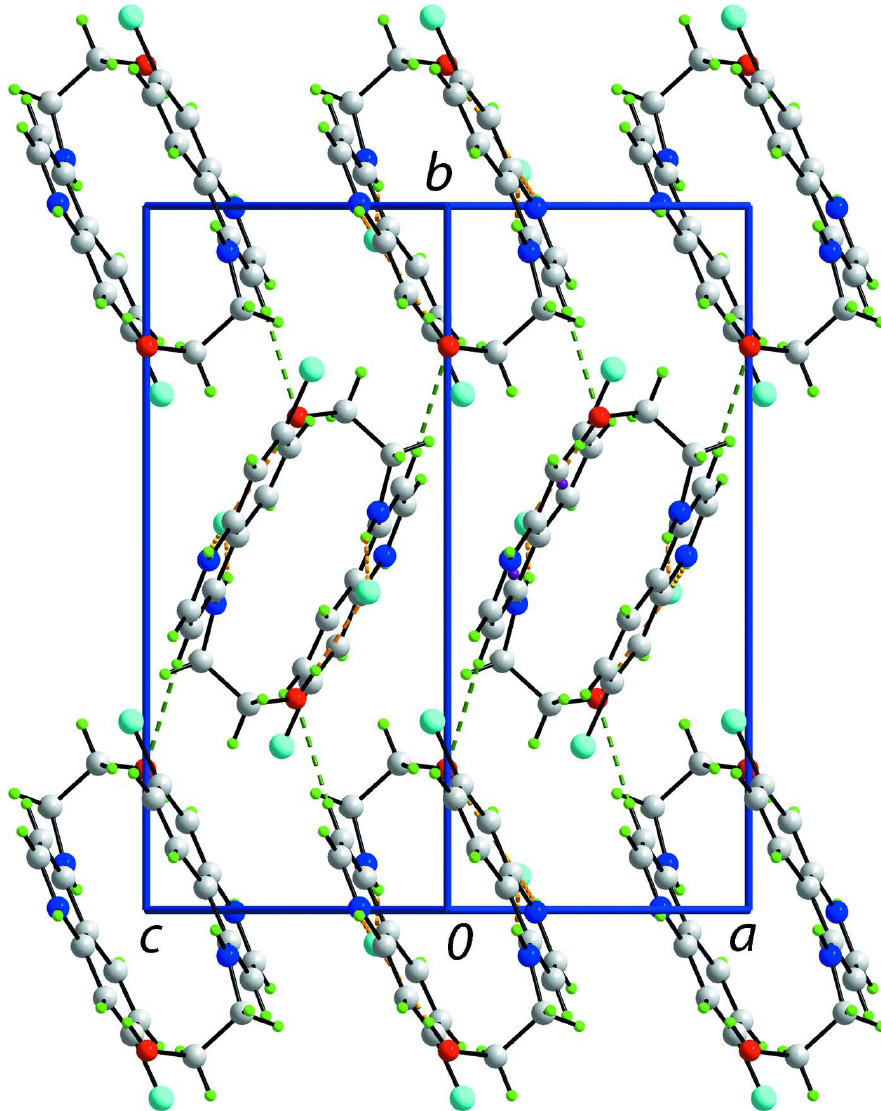
A view in projection down [1 0 1], the direction of the chain shown in Fig. 2, of the unit-cell contents of (I). The O— H···Cl - , N—H···Cl - and C—H···O interactions are shown as orange, blue and green dashed lines,